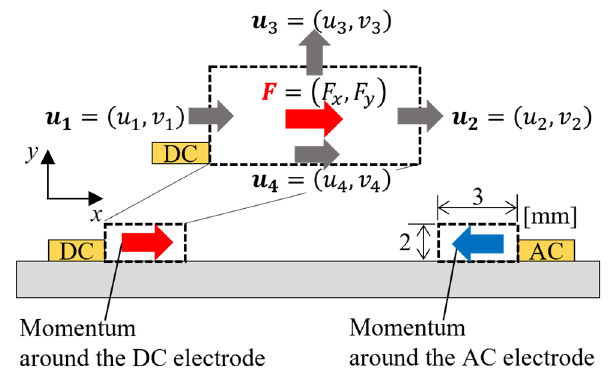
Figure 8. Area for calculating the momentum flow rate from the flow velocity field.